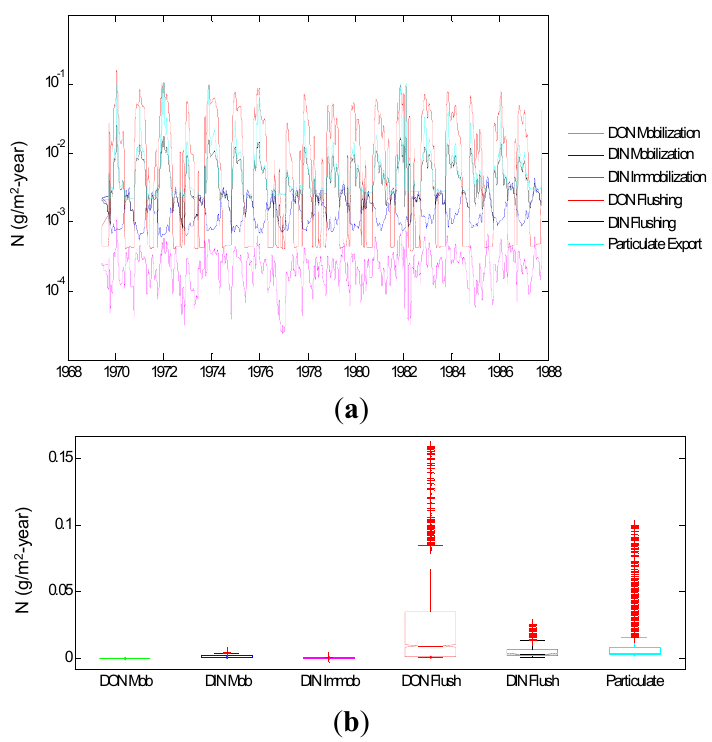
Figure 10. Key modeled rate terms associated with the aquatic environment. ( a ) The plot represents the modeled time series, as indicated in the legend, across the 20 year simulation time frame. These data are summarized and presented as a box and whisker plot ( b ). Note that the y axis in log transformed in the upper plot, but is linear in the lower